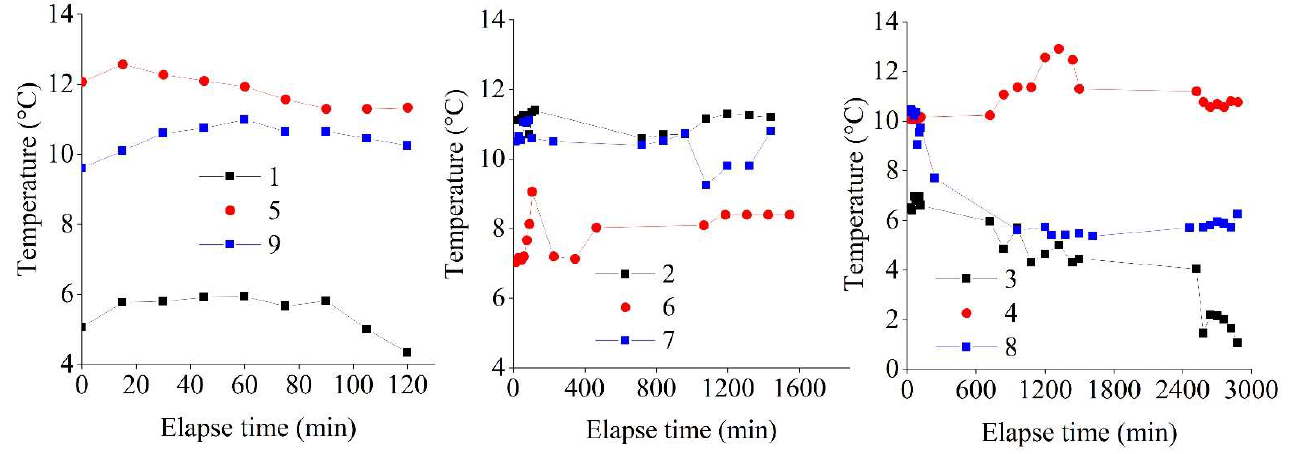
Figure 5. Temperature–time history plots for the tested samples.